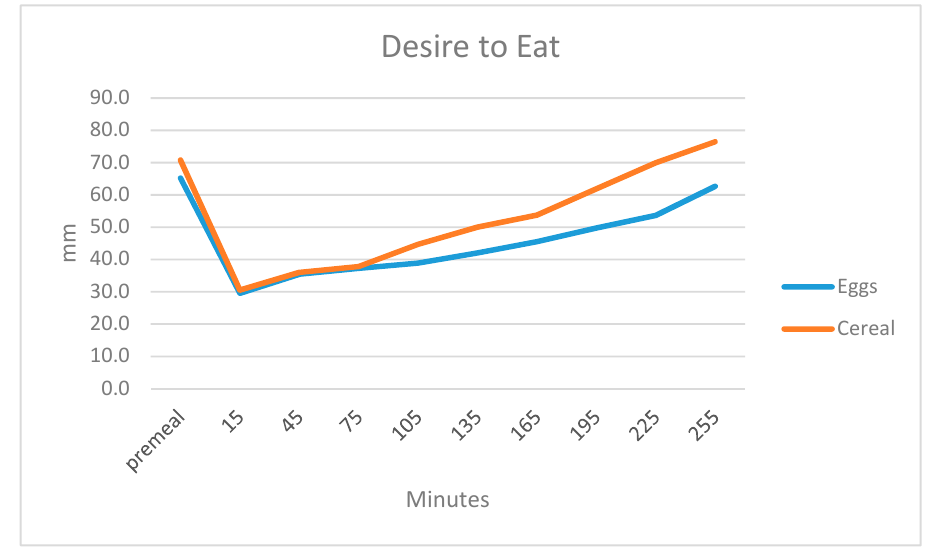
Figure 4. Desire to eat before and 15, 45, 75, 105, 135, 165, 195 and 225 min after finishing breakfast on a 100-mm VAS scale.